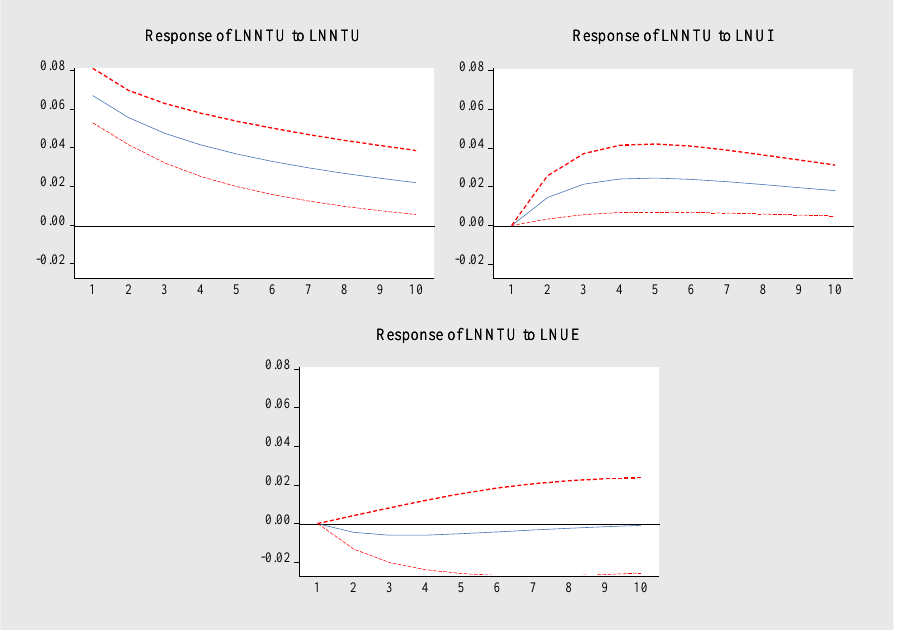
Figure 8. PVAR model robustness test result.